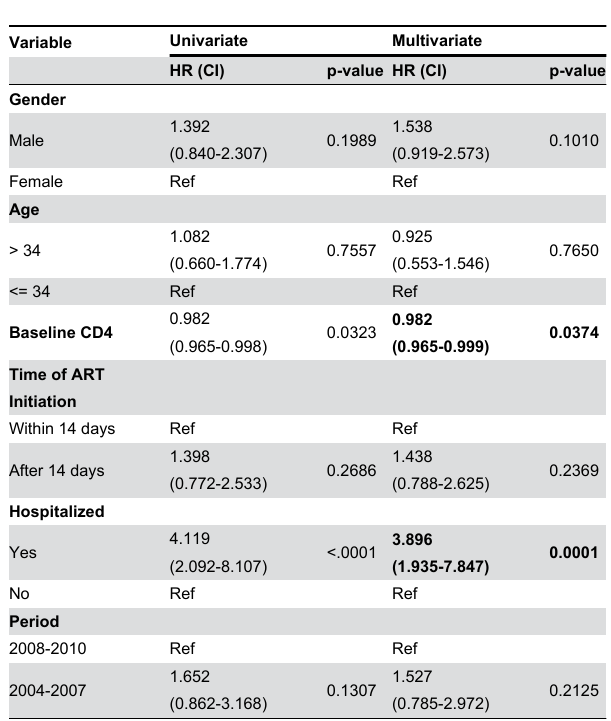
Table 4. Overall Predictors of mortality from HAART